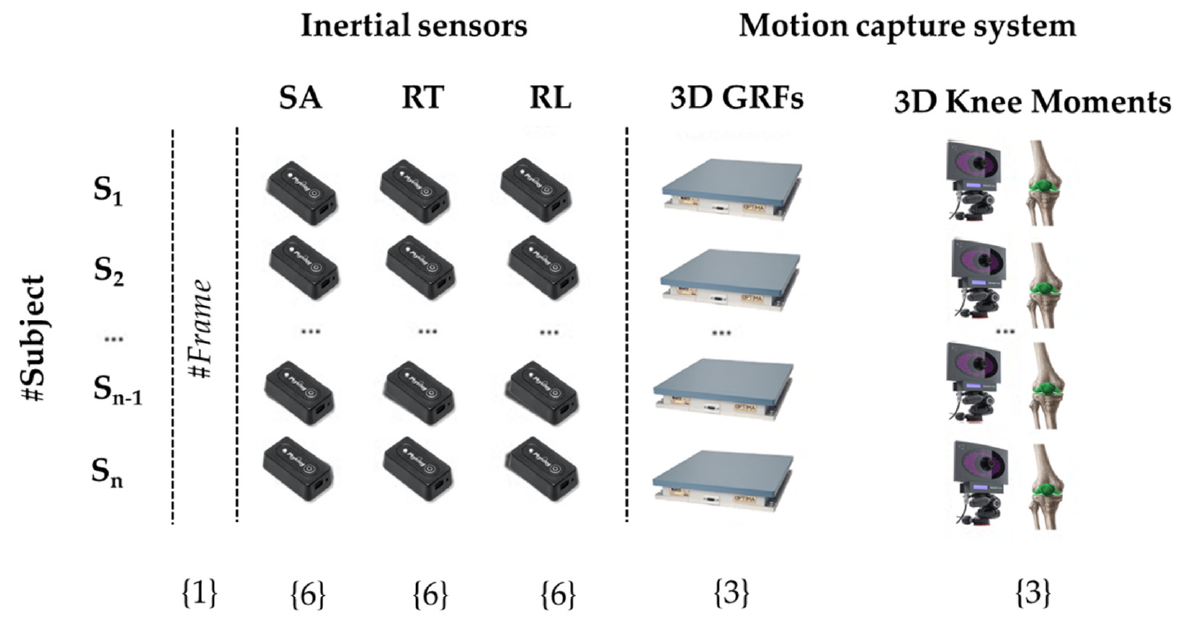
Figure 7. Visual structure of the dataset. The first column contains the reference index of the frame of each jump, columns 2–19 contain the data recorded by the three IMUs, placed on the sacrum (SA), right leg (RL), and right thigh (RT), whilst columns 20–25 contain the 3D right GRFs and the right knee moments. Numbers in parentheses indicate how many features (columns) belong to each